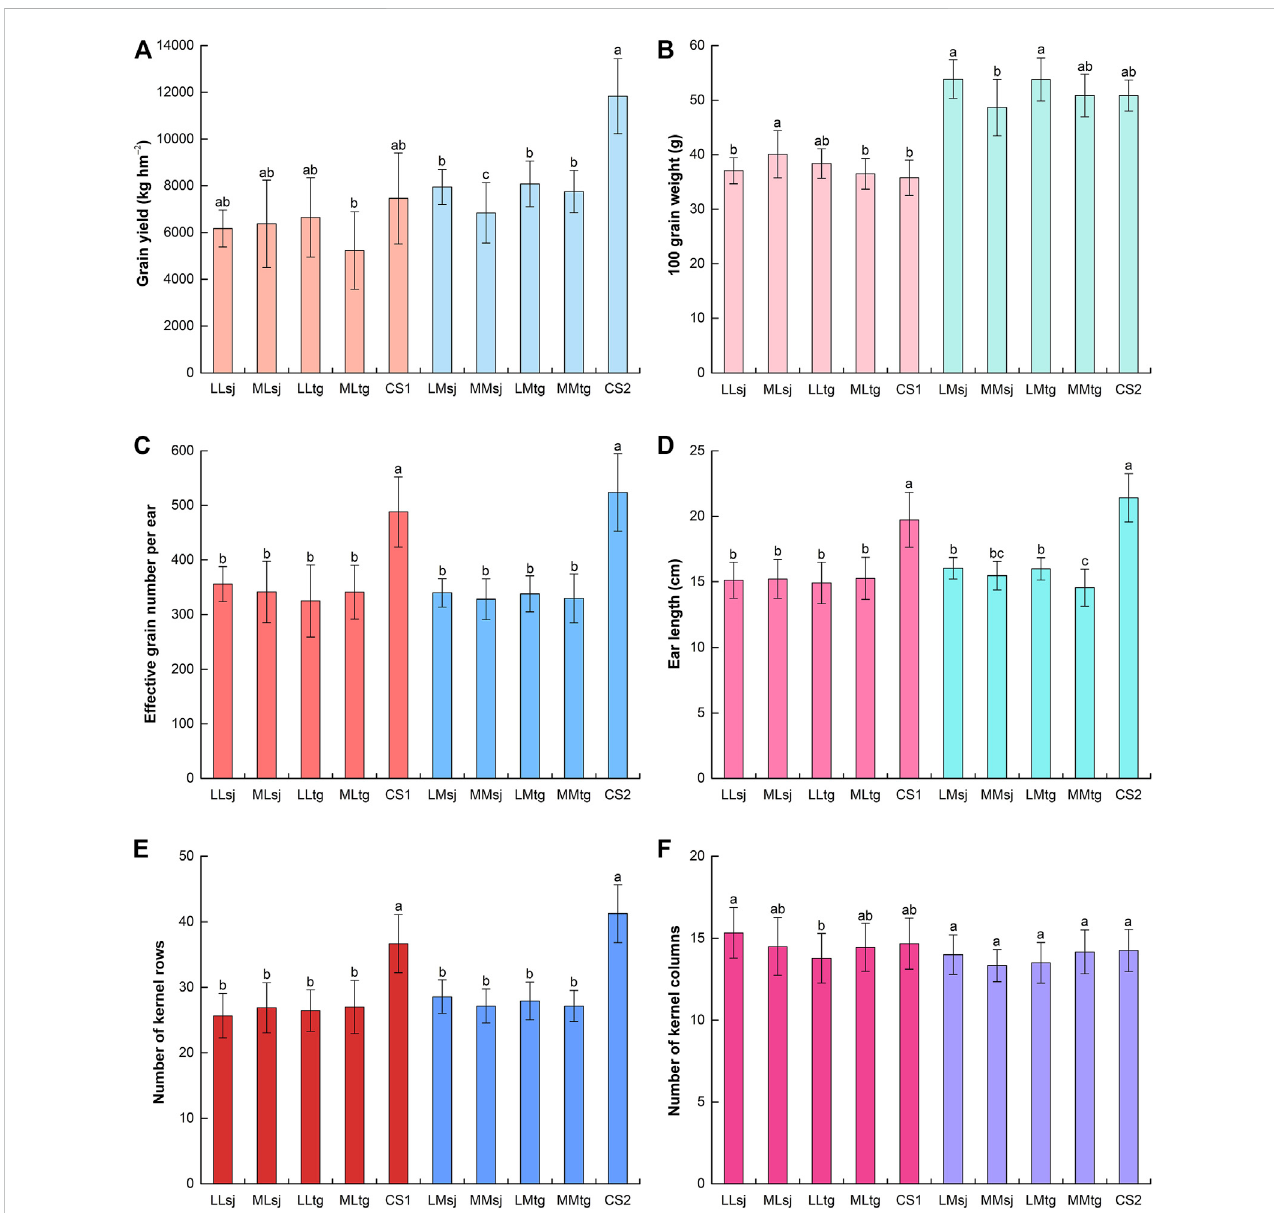
FIGURE 4 Grain yield and yield components in different treatments. (A) grain yield; (B) 100 grain weight; (C) effective grain number per ear; (D) ear length; (E) number of kernel rows; (F) number of kernel columns. Error bars represent standard deviations ( n = 3), different letters in the same row indicated signi fi cant difference among the treatments at 0.05. Note: LLsj, MLsj, LLtg, MLtg, CS1, LMsj, MMsj, LMtg, MMtg, CS2, same to the above